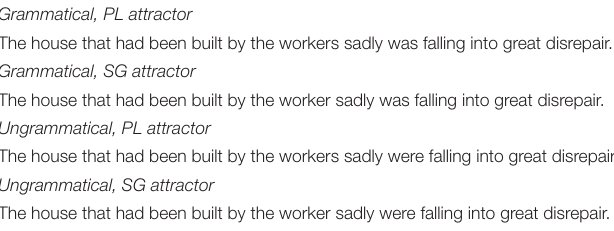
TABLE 7 | Sample set of items for Experiment